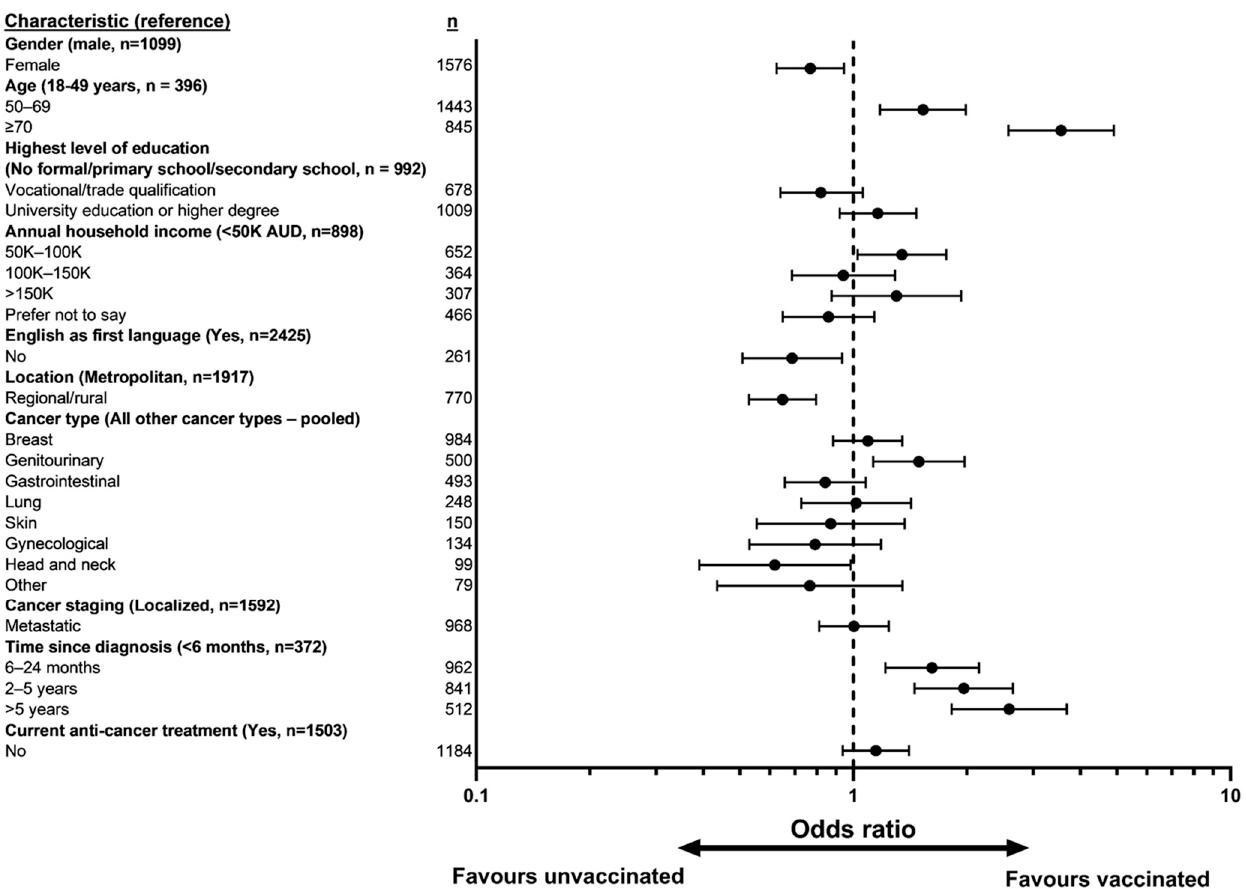
Figure 2. Forest plot of time-adjusted logistic regression model of factors associated with vaccine uptake. Abbreviations: AUD, Australian dollars; K, 1000. (please see Figure S2 for clearer figure) uptake. Abbreviations: AUD, Australian dollars; K, 1000 (please see Figure S2 for clearer